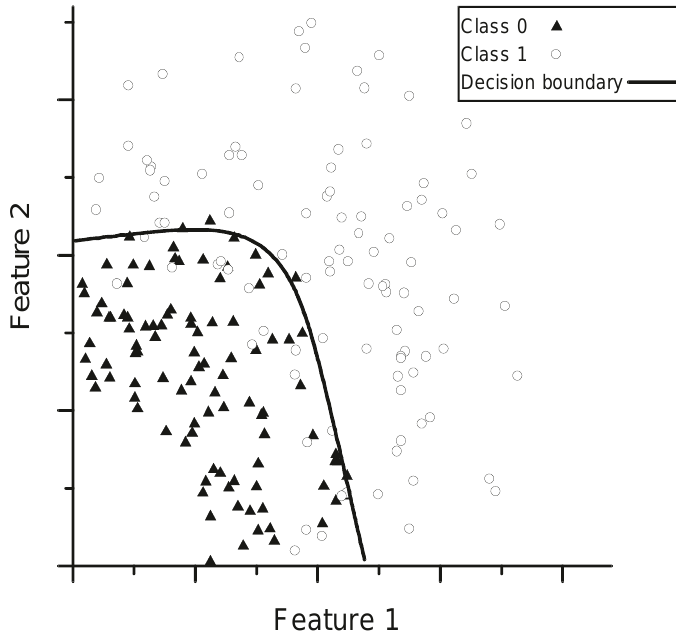
Fig. 6. The decision boundary is shown for a neural network classifier with two hidden